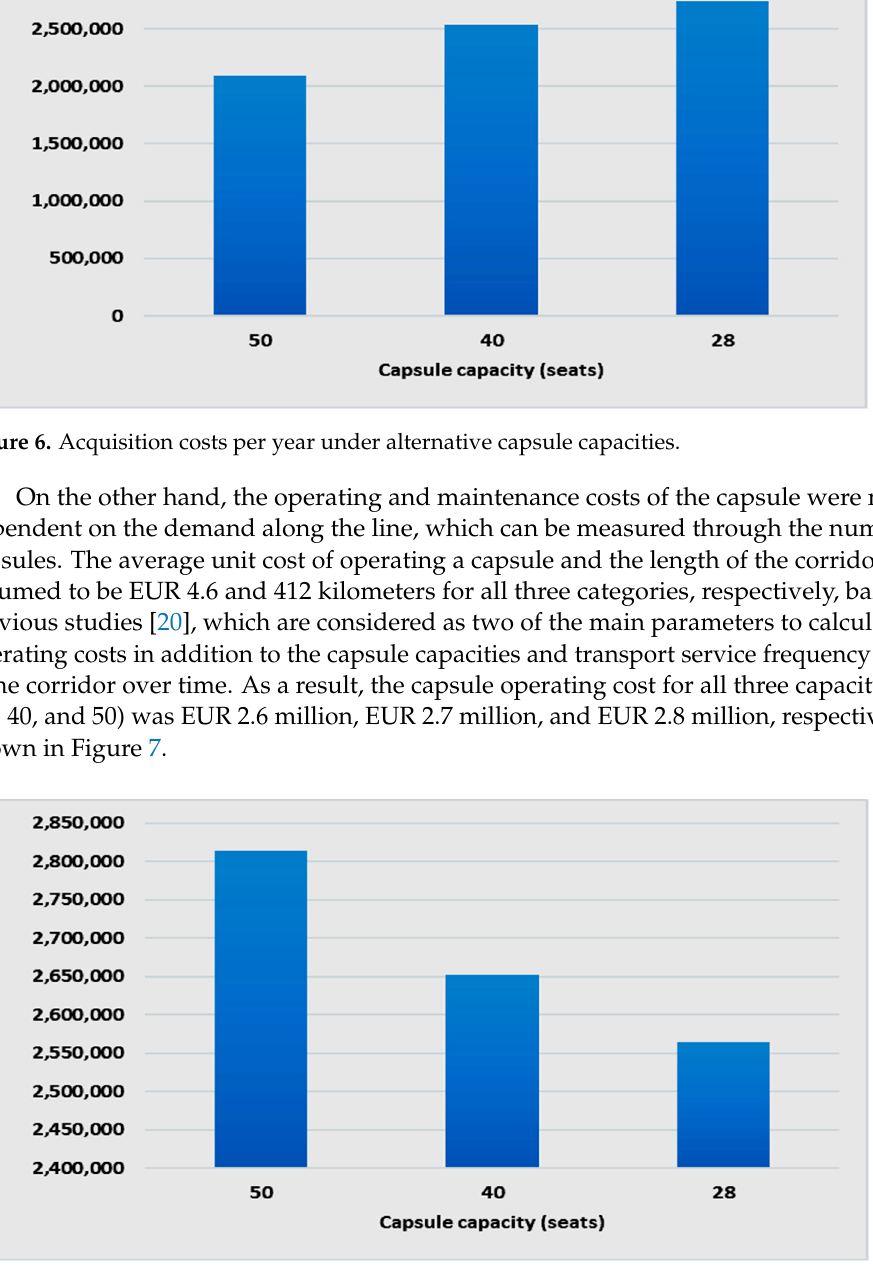
Figure 7. Operating costs per year under alternative capsule capacities.